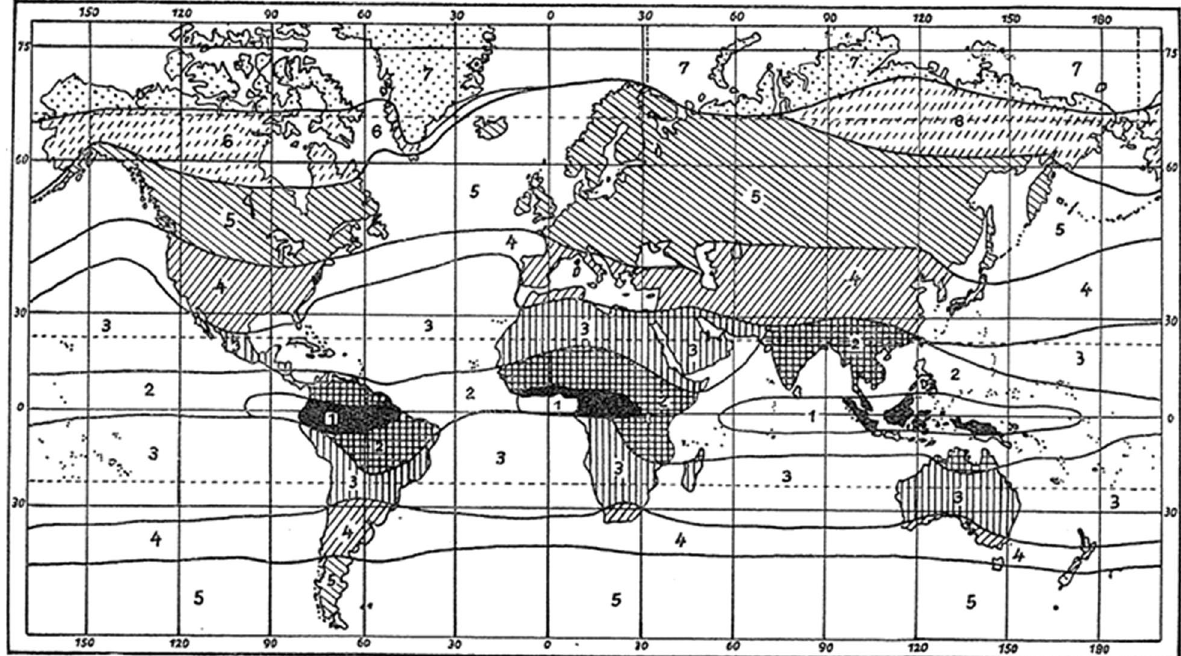
Fig. 1 Alisov’s seven climatic zones (Alisov 1954). 1: Equatorial zone, 2: Subequatorial zone, 3: Tropical zone, 4: Subtropical zone, 5: Polar zone, 6: Subarctic zone, 7: Arctic/Antarctic